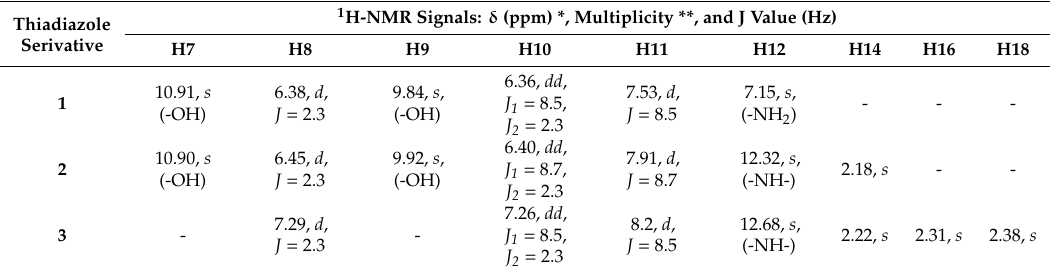
Table 1. 1 H-NMR signals of the 1,3,4-thiadiazole derivatives 1–3. Thiadiazole